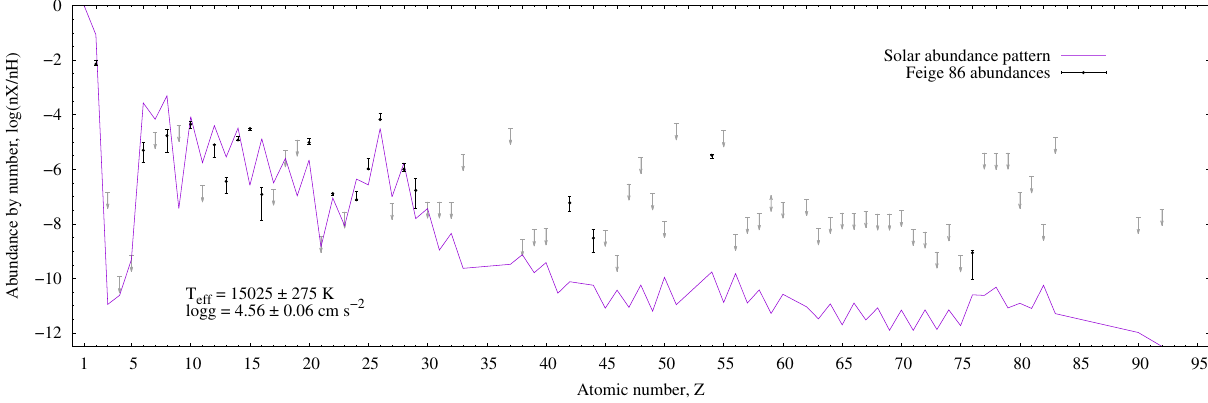
Figure 4. The abundance pattern of Feige86, compared to the solar mixture (Asplund et al. 2009). While most of the heavy metal abun- dances are only upper limits, the overabundance of Xe hints the presence of a hitherto unseen peak of heavy elements.